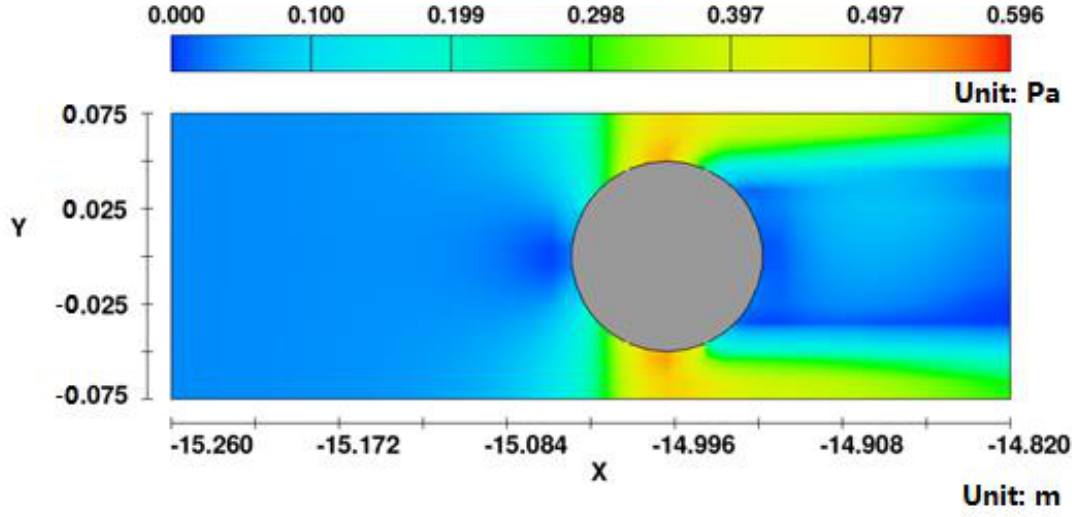
Figure 9. Excess shear stress distribution (0.05 m above the seabed) of Case 1.